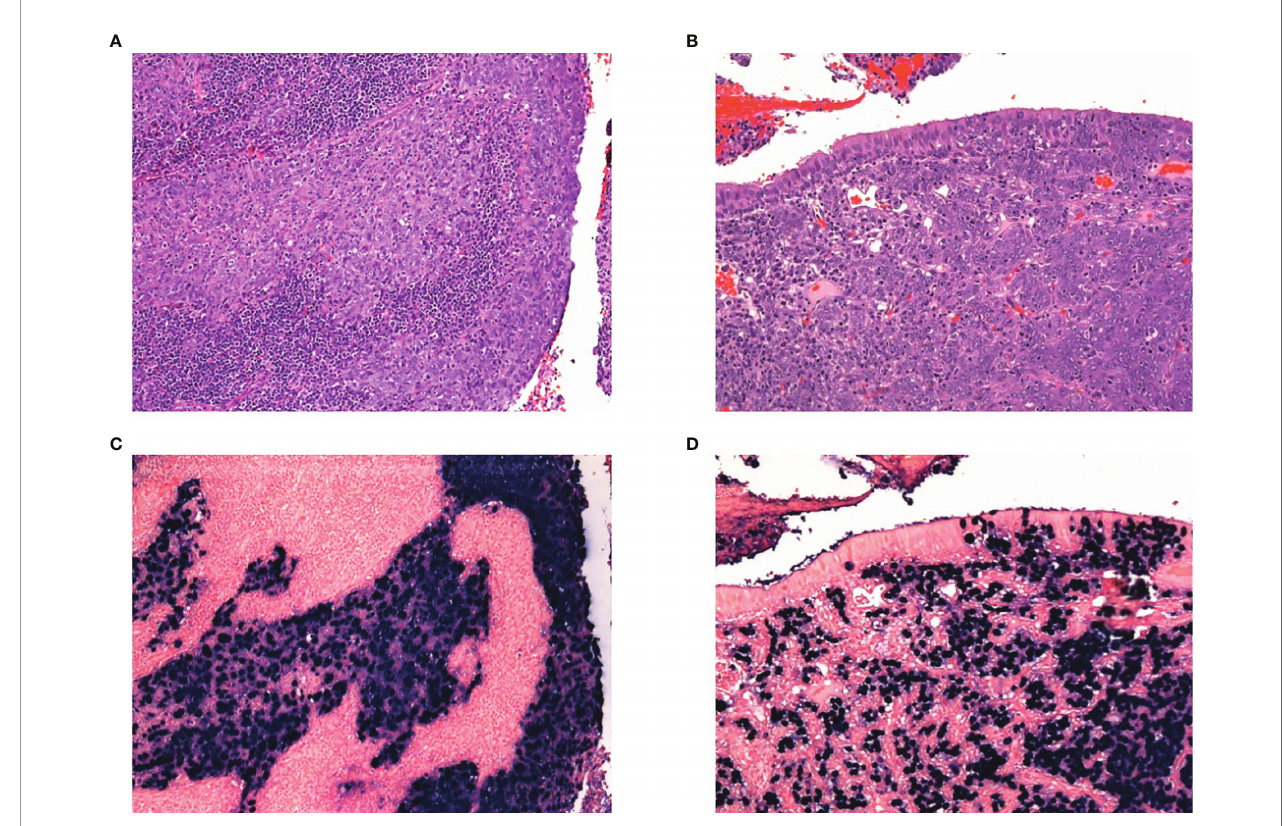
FIGURE 1 | H&E of nasopharyngeal cancer showing tumours with (A) Regaud appearance, showing distinct islands of tumour cells, and (B) Schmincke appearance, with interdigiting tumour cells and in fl ammatory in fi ltrate. Corresponding EBER-ISH for the Regaud and Schmincke patterns in (C) and (D)